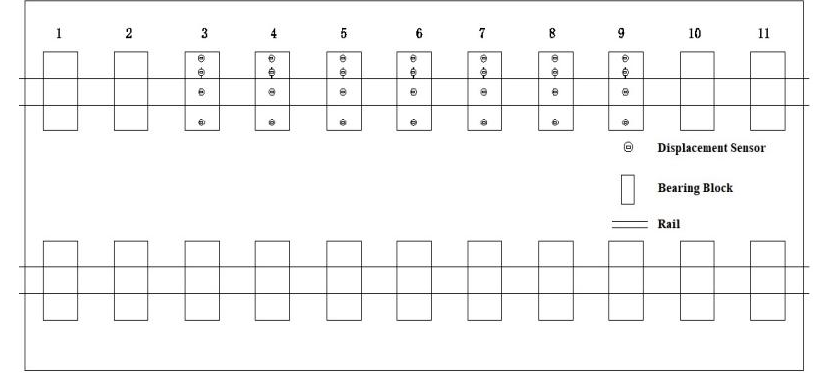
Figure 14. Layout of the second measuring point in working condition.